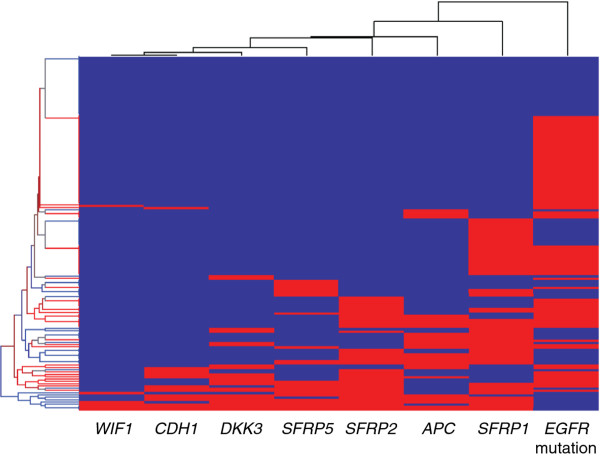
Hierarchical clustering of Wnt antagonist DNA methylation status and EGFR genotype in 155 patients received EGFR-TKI therapy. Red represents methylated gene or mutated EGFR, while blue represents unmethylated gene or wild-type EGFR, The figure of hierarchical clustering showed that the epigenotype of Wnt antagonist genes had similar patterns, which were different from the genotype of EGFR.